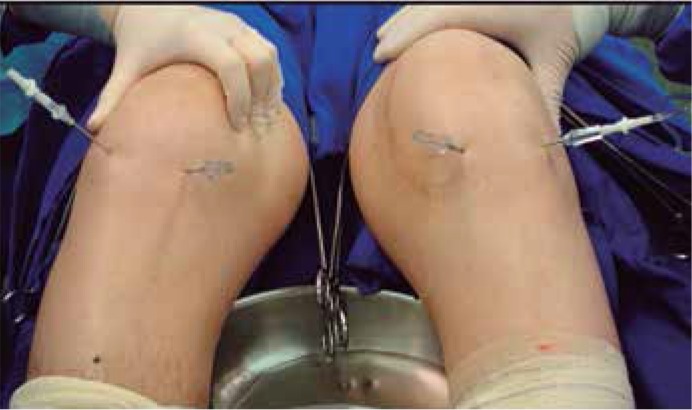
Arthroscopic lavage of left and right knees.